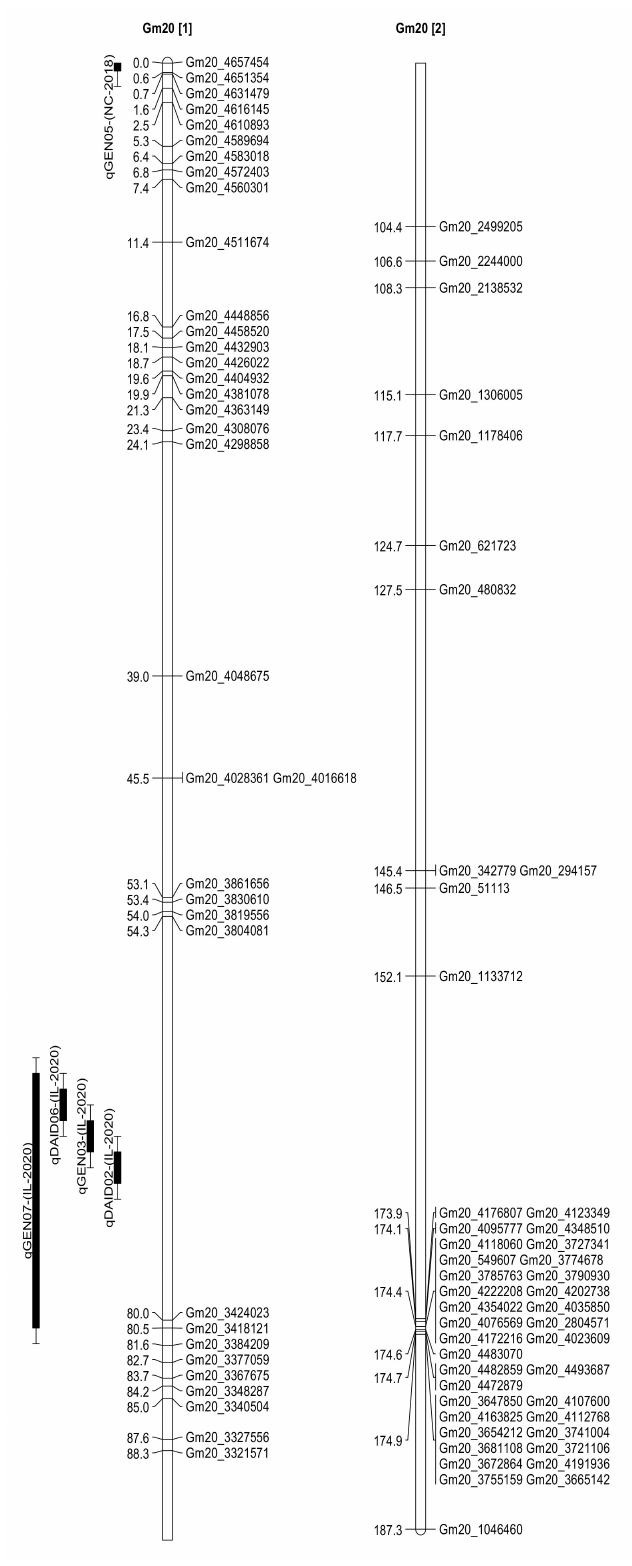
Figure 3. Positions of QTL that control seed genistein (qGEN), daidzein (qDAID), and glycitein (qGLY) contents on Chrs. 2, 4, 5, 6, 10, 12, 15, 19, and 20. QTL names are followed by a number, location, and year in which they are identified. For example, qGEN01-(NC-2018). The full SNP-based genetic linkage map of Forrest by Williams 82 recombinant inbred line (RIL) population ( n = 306) of soybean is shown in Figure